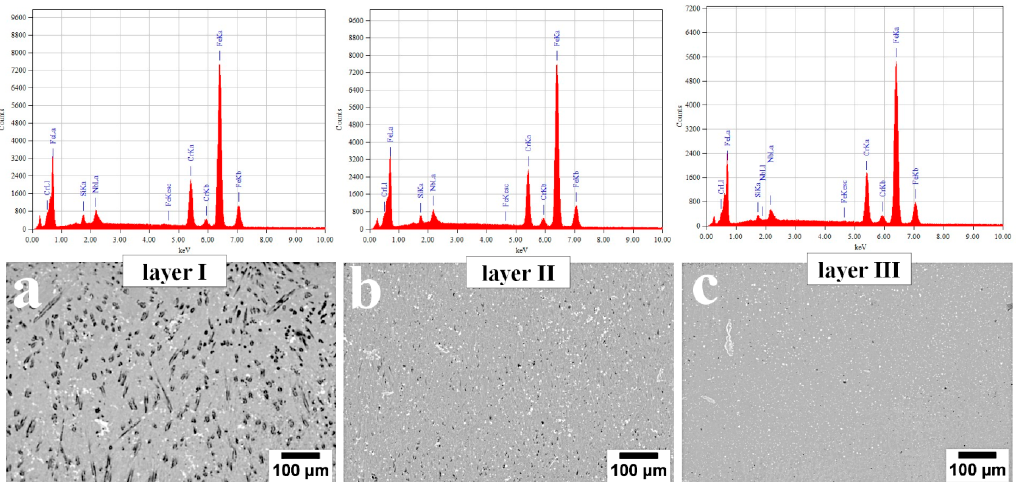
Figure 10. Energy-dispersive X-ray spectroscopy (EDX) obtained from distinguished areas of the cladding produced by welding. ( a ) Layer I; ( b ) Layer II; ( c ) Layer III. Scanning electron microscopy. Table 1. Quantitative results of the chemical composition microanalysis from the areas shown in Figure 10. Chemical Composition (wt. %) Layer Cr